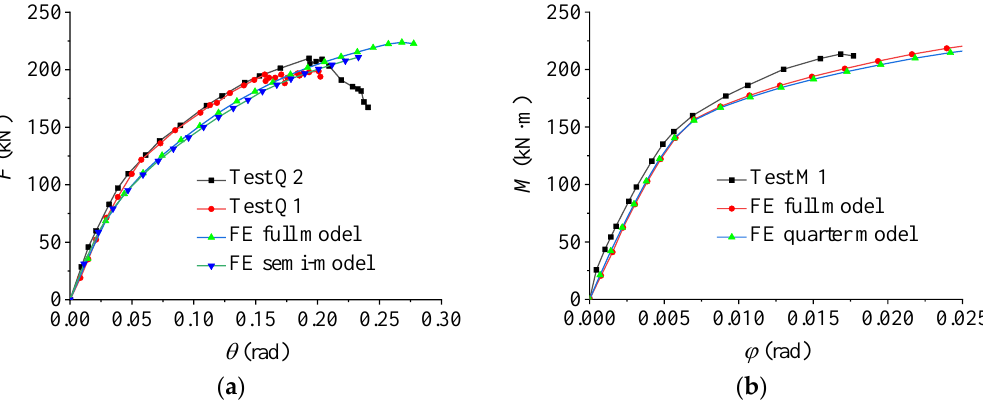
Figure 5. Comparison between test and FE results. ( a ) Q series tests and FE analysis results; ( b ) M series tests and FE analysis results.